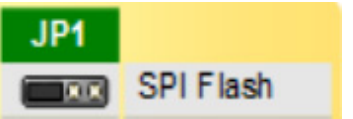
Figure 18. Jumper for SPI Quad mode Flash programming mode.